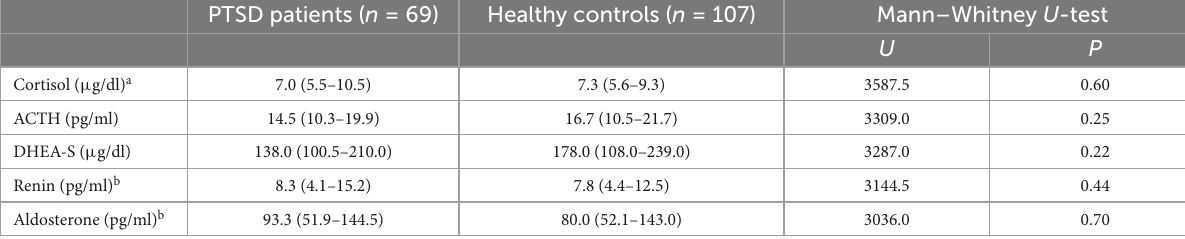
TABLE 2 Blood levels of HPA axis and RAA system hormones in patients and